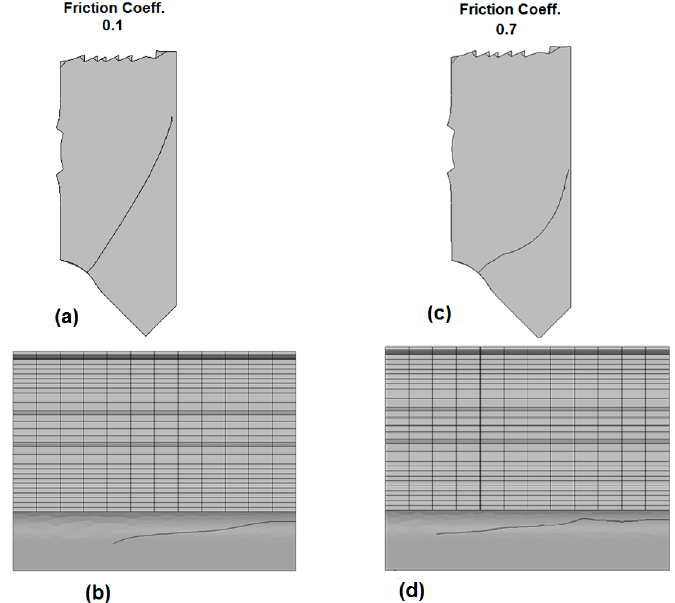
Figure 26. Crack shape and direction. A direct comparison between low and high friction coefficients. The geometry is a 45° short flank. (a) Friction coefficient = 0.1 front view; (b) Friction coefficient = 0.1 top view; (c) Friction coefficient = 0.7 front view (d) Friction coefficient = 0.1 top view.